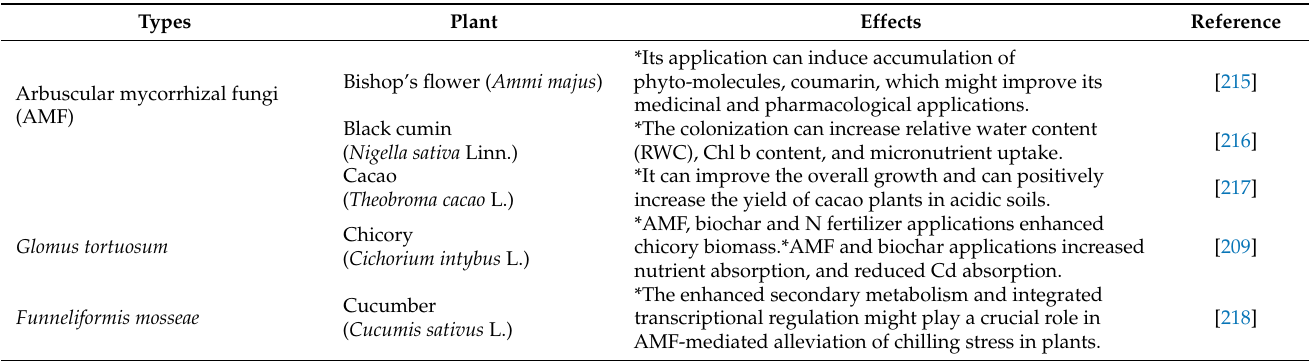
Table 3. The most important effects of AMF on horticultural